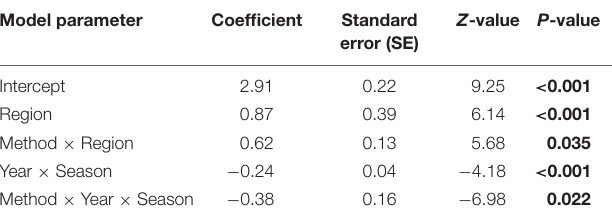
TABLE 2 | A Poisson generalized linear mixed model (GLMM) investigating the fixed effects of method (observer-based counts and photo-identification) and region (SWH, SNB, and LZB), the random effects of survey year (2013-2019) and season (spring, summer, autumn, and winter), and the mixed effects of their interactions on group size of humpback dolphins.